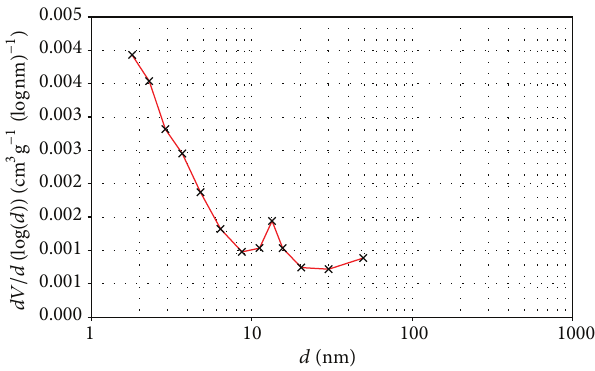
Figure 3: The pore-size distribution of the LF slag.